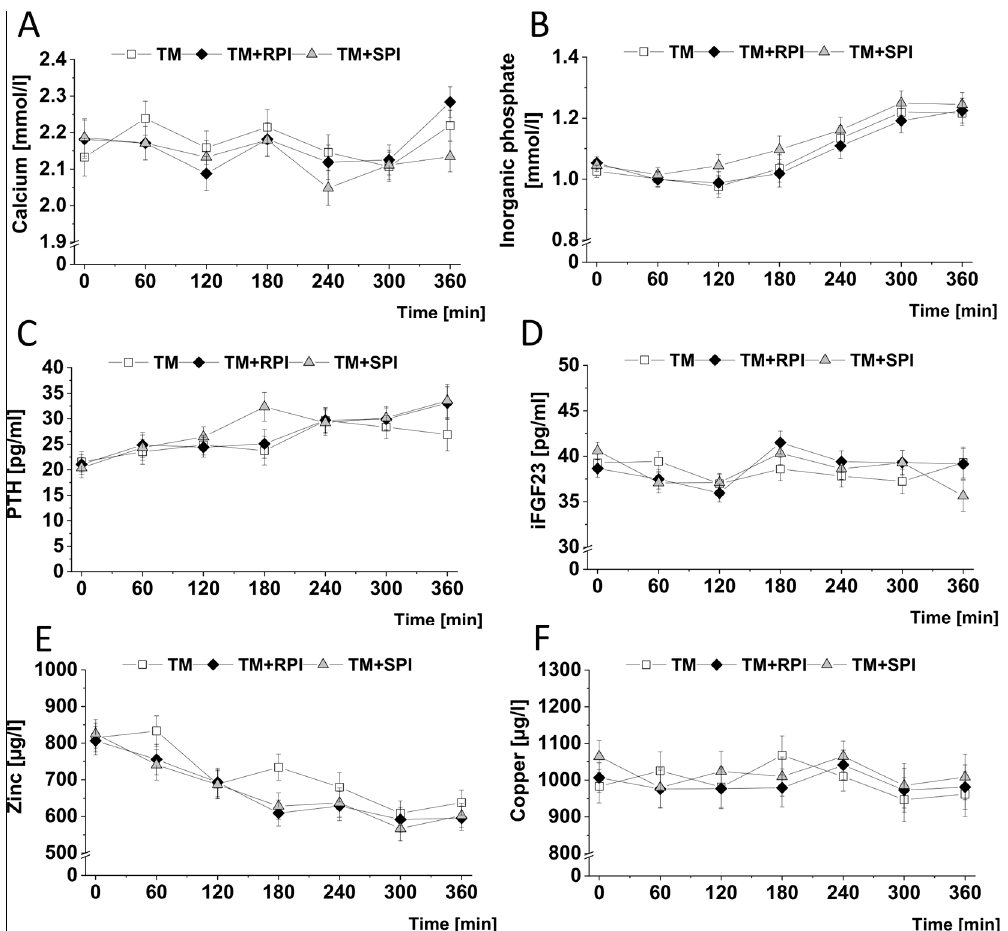
Figure 6. Postprandial response of the test meal (TM) with either no additional protein as reference ( □ ), 28 g rapeseed protein isolate (RPI) ( ♦ ), or 28 g soy protein isolate (SPI) ( ▲ ) with regard to plasma calcium ( A ), inorganic phosphate ( B ), PTH ( C ), iFGF23 ( D ), zinc ( E ), and copper ( F ). Differences in mineral and related hormone concentrations after the ingestion of the three test meals over 6 h were evaluated with a mixed model to test the e ff ects of treatment, time, and their interaction (treatment × time) on each parameter. The value at baseline (before treatment) was considered a covariate. All p values were adjusted according to the Tukey–Kramer multiple group comparison procedure. For time-point analysis, the paired t-test was applied. Significance was accepted as p < 0.05. Data are presented